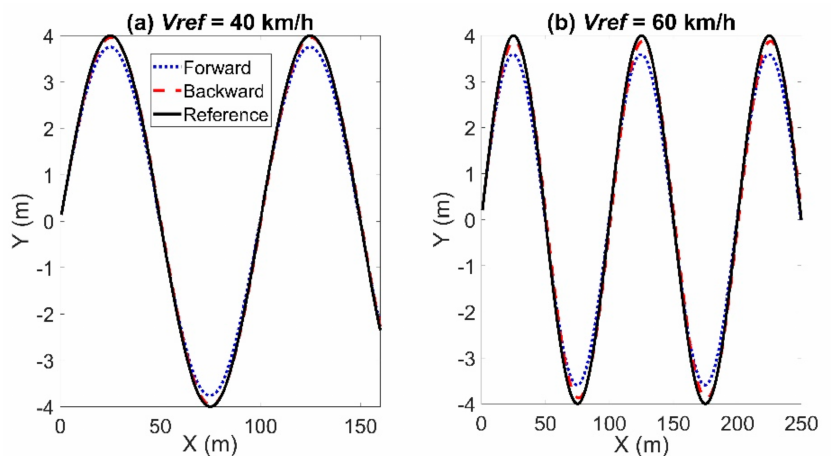
Figure 4. Results for tracking the sinusoidal trajectory with T s = 0.05 s: left for Case ( a ) with Vref = 40 km/h and right for Case ( b ) with Vref = 60 km/h.